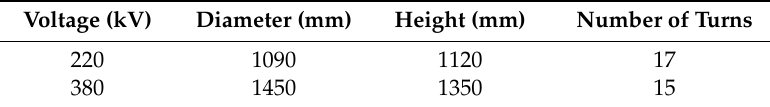
Table 2. Parameters of the considered line trap coils.